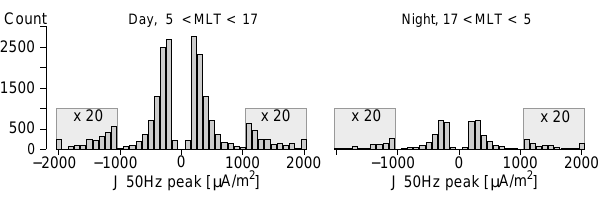
Fig. 7. Distribution of the 50-Hz peak currents separated for daytime and nighttime. Events with (cid:12) (cid:12) (cid:12) j 50Hz , peak (cid:12) > 2000 µ A / m 2 are grouped together in one bin. (cid:12) (cid:12) Bin heights for (cid:12) j 50Hz , peak (cid:12) > 1000 µ A / m 2 are magnified by a factor of 20. Fig. 8. Locations (in MLAT) of 50-Hz KSFAC peaks as a function